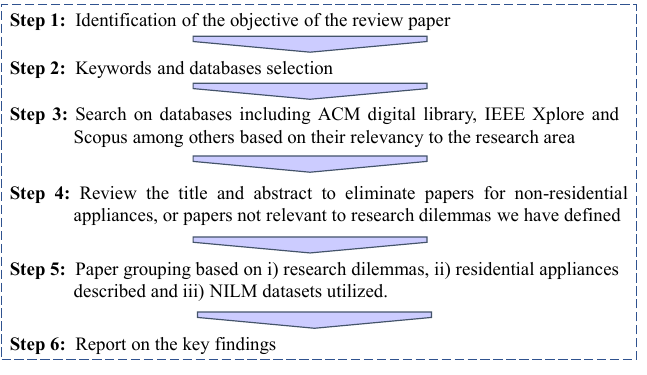
Figure 2. Paper selection